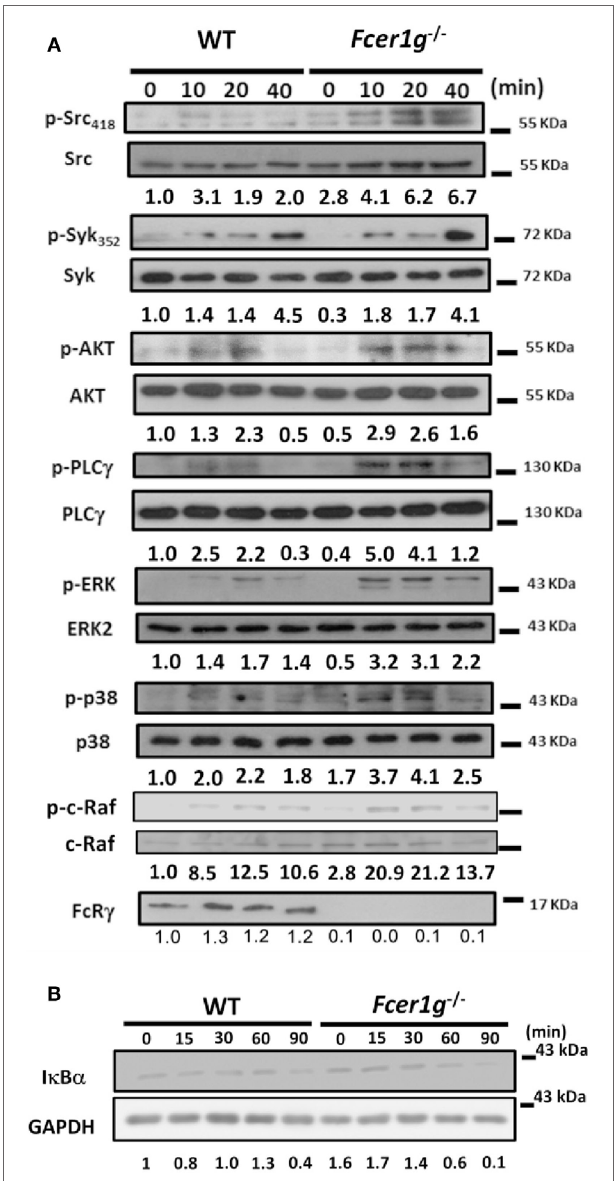
FigUre 7 | Enhanced Dectin-1 Signaling in Fcer1g − / − DCs. Six-day-cultured BMDCs derived from WT and Fcer1g − / − mice were collected and starved in serum-free RPMI. After 3 h, cells were treated with dZym and lysed at indicated time points. The proteins were separated by SDS-PAGE, transferred to PVDF membranes, and then analyzed by Western blot. The detection of phosphorylated and total proteins of Src, Syk, AKT, PLC γ , ERK, p38MAPK, and c-Raf (a) , and total proteins of I κ B α and GAPDH (B) , were shown. Quantification was determined by densitometry using ImageJ software and the number represented the fold of each (phosphoprotein/total protein) value normalized to the (phosphoprotein/total protein) value of untreated WT control (WT 0 min). All data shown were representative from three to five independent